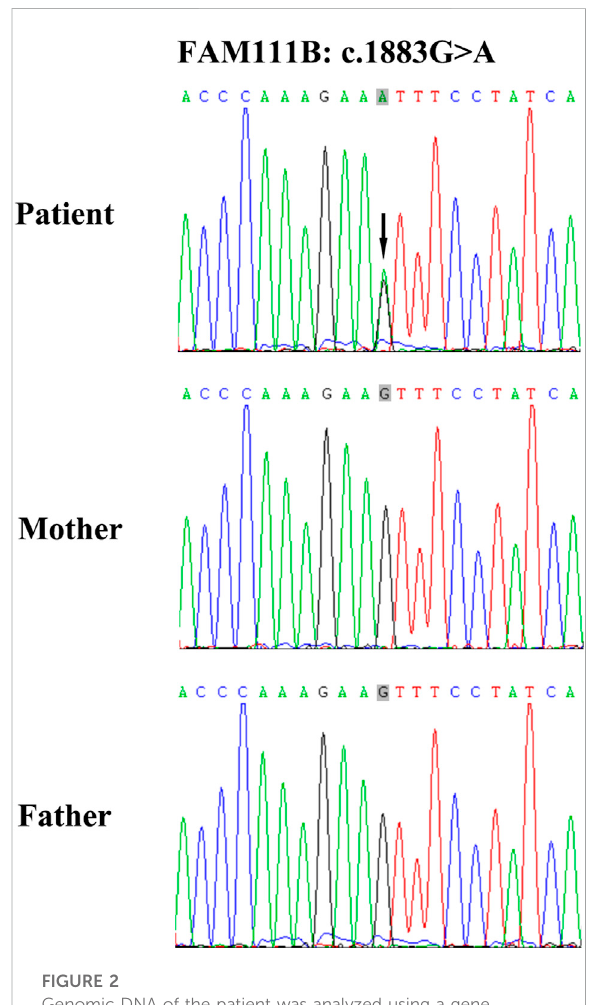
FIGURE 2 Genomic DNA of the patient was analyzed using a gene probe consisting of 541 genetic loci of Geno dermatoses. Sequences were aligned to GRCh38. The c.1883G > A mutation in exon four exhibited a heterozygous point mutation in the patient, indicated by the black arrow, which was absent in his unaffected